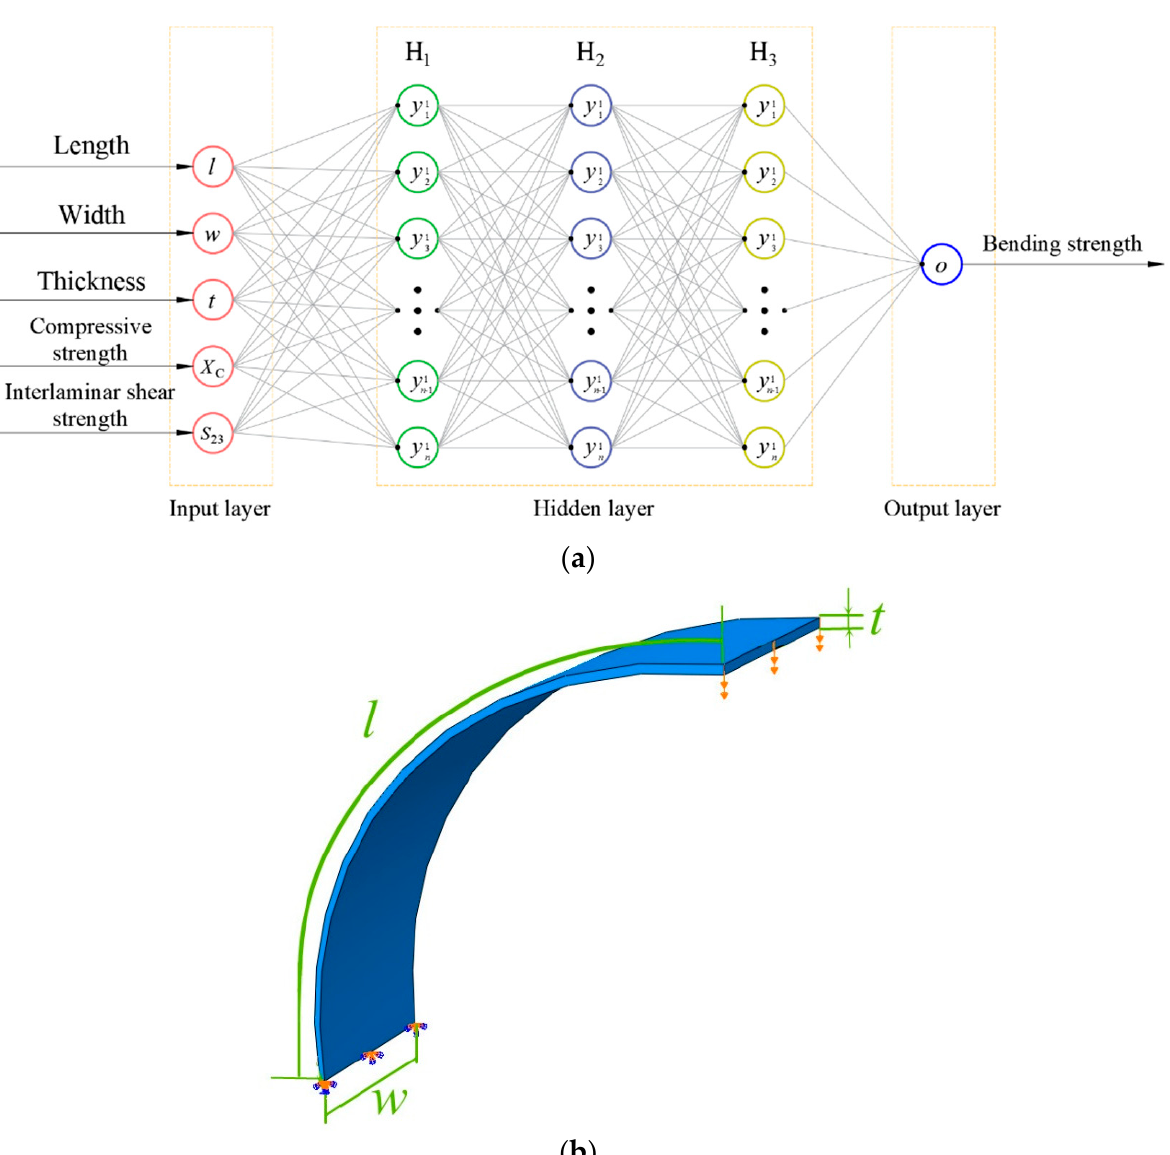
Figure 9. ( a ) Neural network topology and the ( b ) geometry of the FE model (lower connector’s arc part).